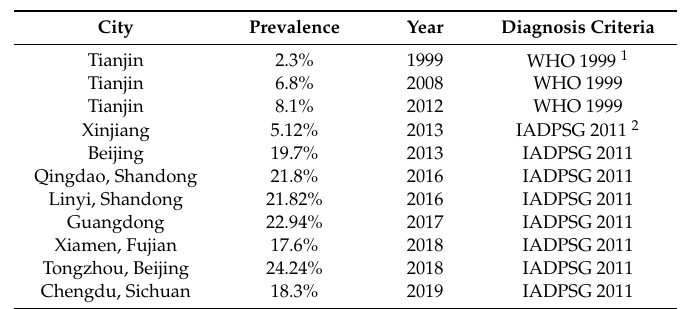
Table 1. The prevalence of GDM in di ff erent cities and regions of